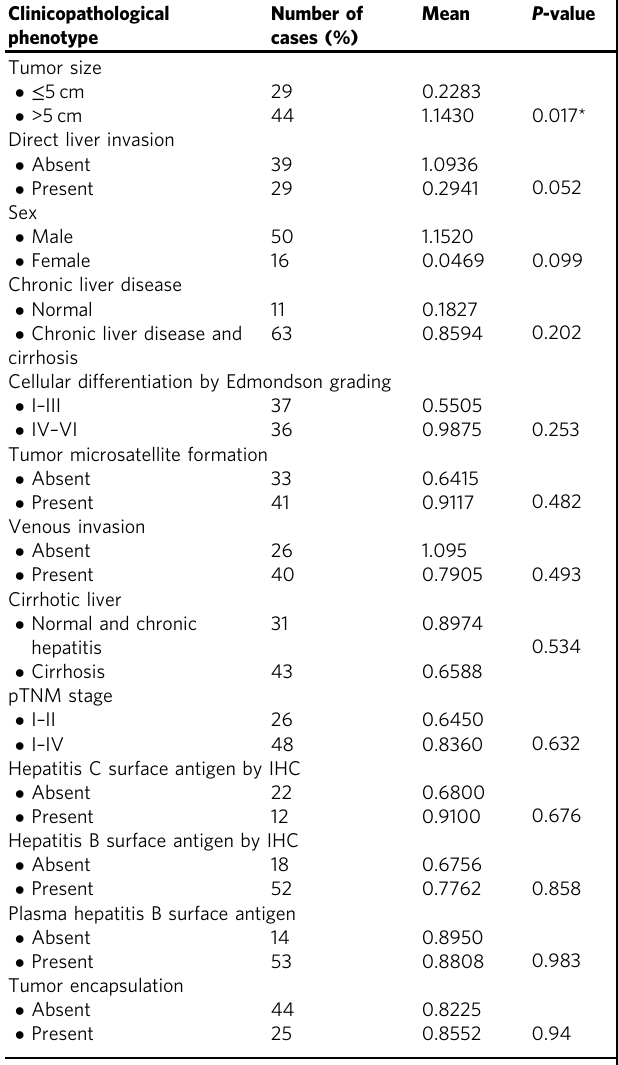
Table 1 Clinicopathological correlation of EHD2 overexpression in human HCC. Clinicopathological